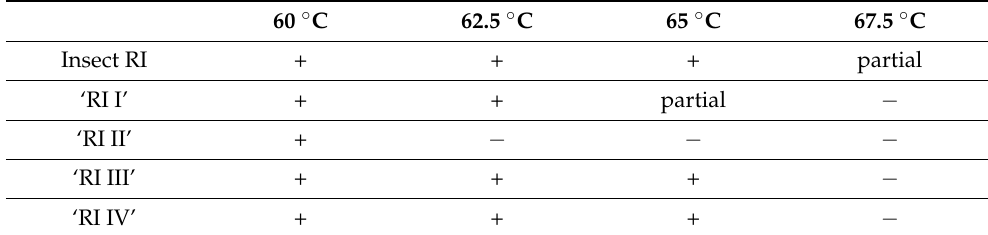
Table 1. Remaining activity of different ribonuclease inhibitors after incubation at the marked